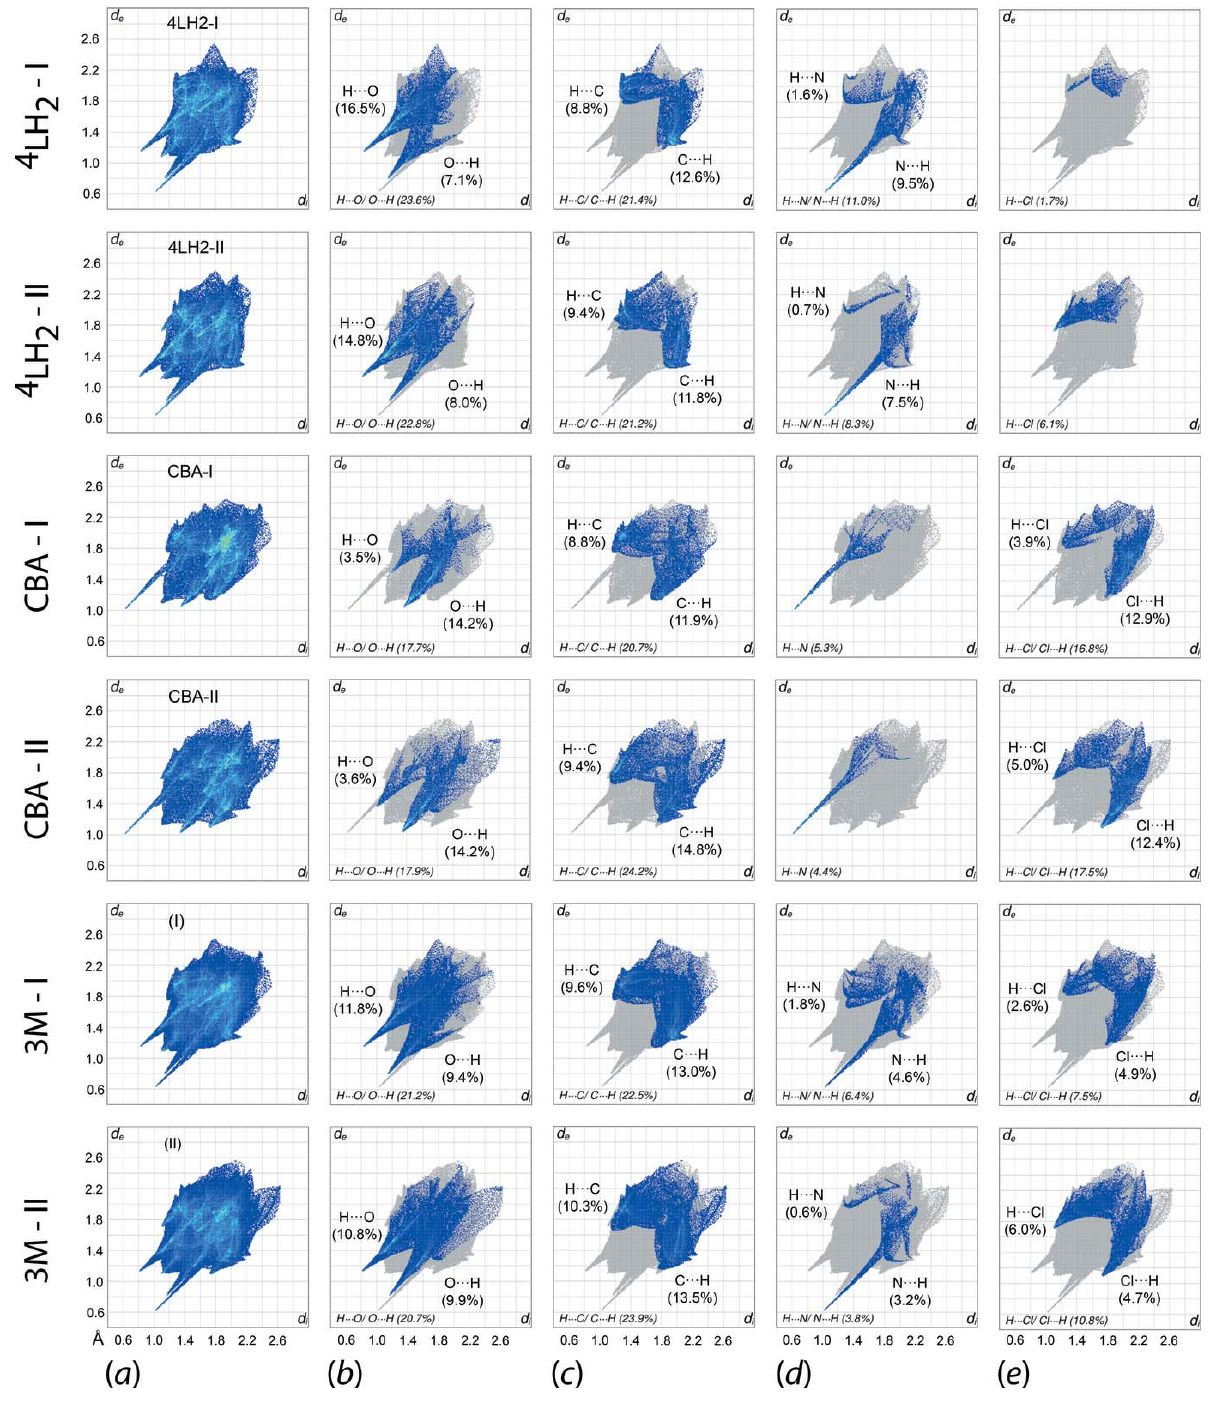
Figure 8 ( a ) The overall two-dimensional fingerprint plots for 4 L H 2 -I, 4 L H 2 -II, CBA-I, CBA-II, 3M-I and 3M-II, and those delineated into ( b ) H (cid:2)(cid:2)(cid:2) O/O (cid:2)(cid:2)(cid:2) H, ( c ) H (cid:2)(cid:2)(cid:2) N/N (cid:2)(cid:2)(cid:2) H, ( d ) H (cid:2)(cid:2)(cid:2) C/C (cid:2)(cid:2)(cid:2) H and ( e ) H (cid:2)(cid:2)(cid:2) Cl/Cl (cid:2)(cid:2)(cid:2) H contacts, with the percentage contributions specified within each surface at the point of contacts calculated with Crystal and +0.0263 a.u., respectively. Therefore, the C7 (cid:2) (cid:2) (cid:2) Cl1 and Explorer 17 employing B3LYP/6-31G( d , p ) are comparable to C14 (cid:2) (cid:2) (cid:2) Cl2 interactions are dispersive in nature. On the other the data obtained from Gaussian 16 , in which Cl1, O1, Cl2 and hand, the apparent charge complementarity between the Cl2 O2 possess charges of +0.0054, (cid:4) 0.0147, +0.0054 and (cid:4) 0.0125 and H25 atoms, which align around a centre of inversion as atomic units (a.u.), respectively; while the C7 and C14 atoms described above, indicate the existence of an electrostatic each exhibit a weak electrostatic potential charge of +0.0251 interaction between two CBA-II molecules, Fig. 5( d ). 250 Tan and Tiekink (cid:5) C 14 H 14 N 4 O 2 (cid:2) 2C 7 H 5 ClO 2